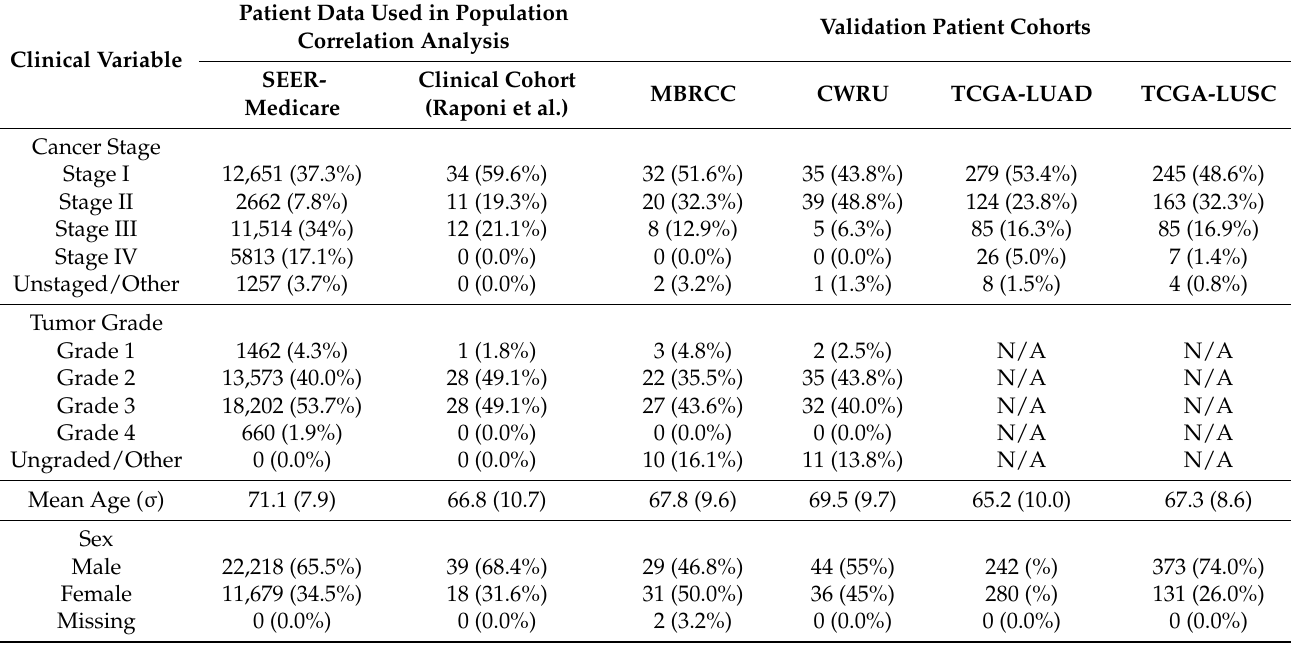
Table 1. Summary of demographic and clinical variables for patients in the linked SEER-Medicare database and the clinical cohort used in the population correlation analysis and four validation cohorts from Mary Babb Randolph Cancer Center (MBRCC), Case Western Reserve University (CWRU), TCGA-LUAD, and